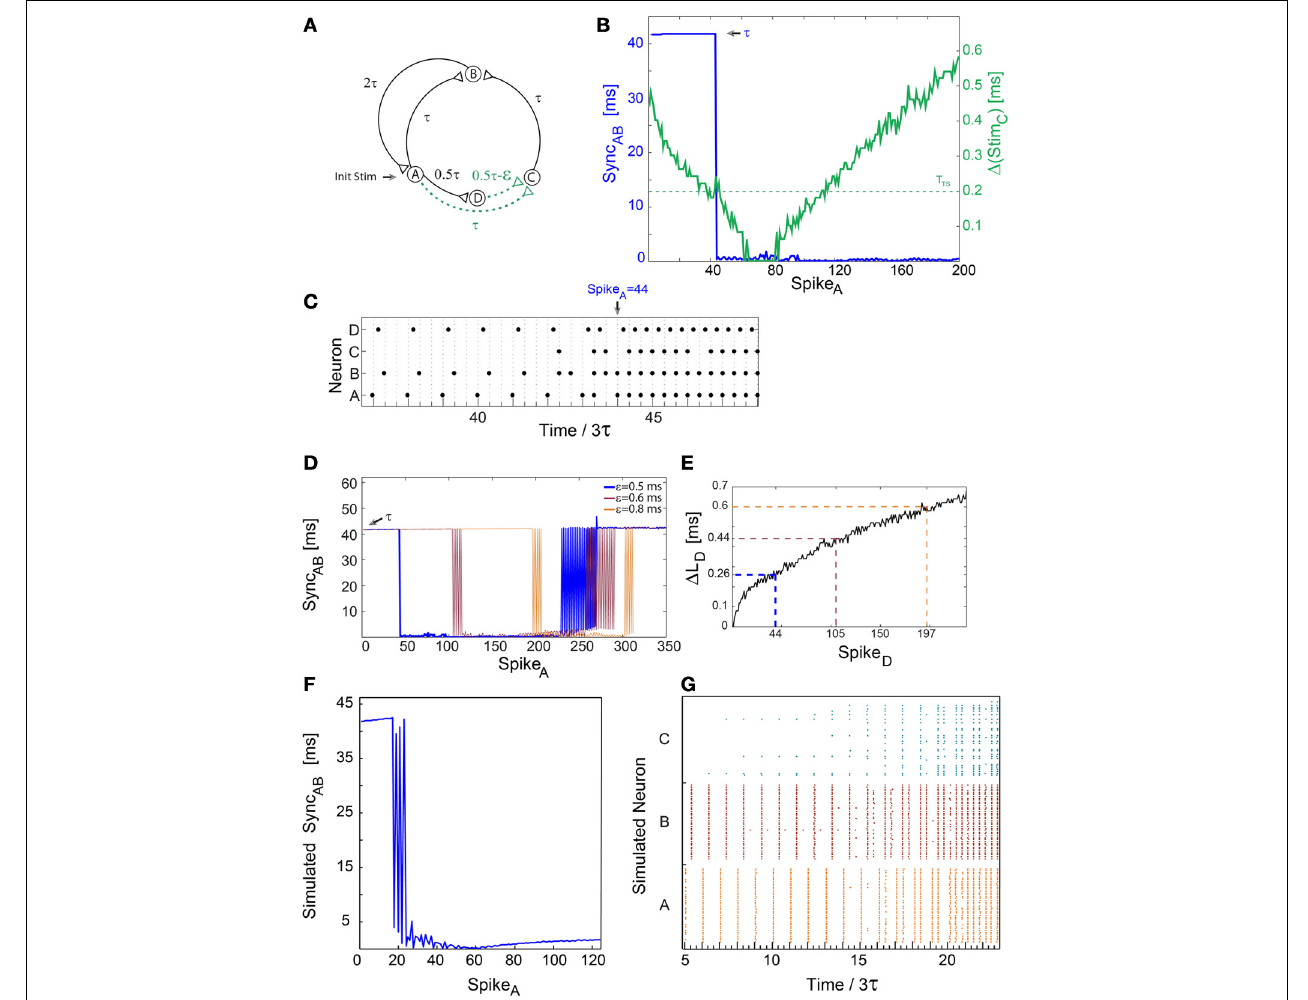
FIGURE 2 | A sudden leap to synchrony accompanied by tripled frequency. Notations used: Sync AB , the absolute time-lag between the spikes of neurons A and B; (cid:2) (Stim C ), the absolute time difference between two weak stimulations to neuron C; (cid:2) L D , the increase in response latency of neuron D after n evoked spikes. (A) Schematic of a neuronal circuit as in Figure 1A , however, the delay from neuron B to A is now 2 τ . (B) Experimental measurements of (cid:2) (Stim C ), similar to Figure 1B , with ε ≈ 0 . 5ms, 3 τ = 125ms and T TS ≈ 0 . 2 (presented by the dashed horizontal green line). Sync AB , (blue line) indicating a sudden leap from τ ≈ 125/3ms to nearly zero-lag synchronization. (C) Spike trains of the four neurons. A sudden leap to synchronization, Sync AB ≈ 0, occurs at time/3 τ = 44 (at spike 44 of neuron A) consecutive to three evoked spikes of neuron C. This is accompanied by tripled firing frequency of neurons A and B, from ∼ 8 to ∼ 24Hz. Sync AB ≈ 0 is robust to response